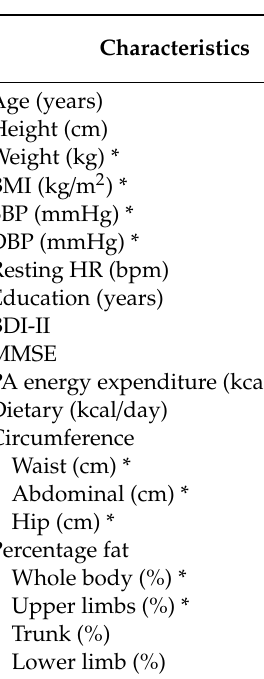
Control Group Obese (n = 26)